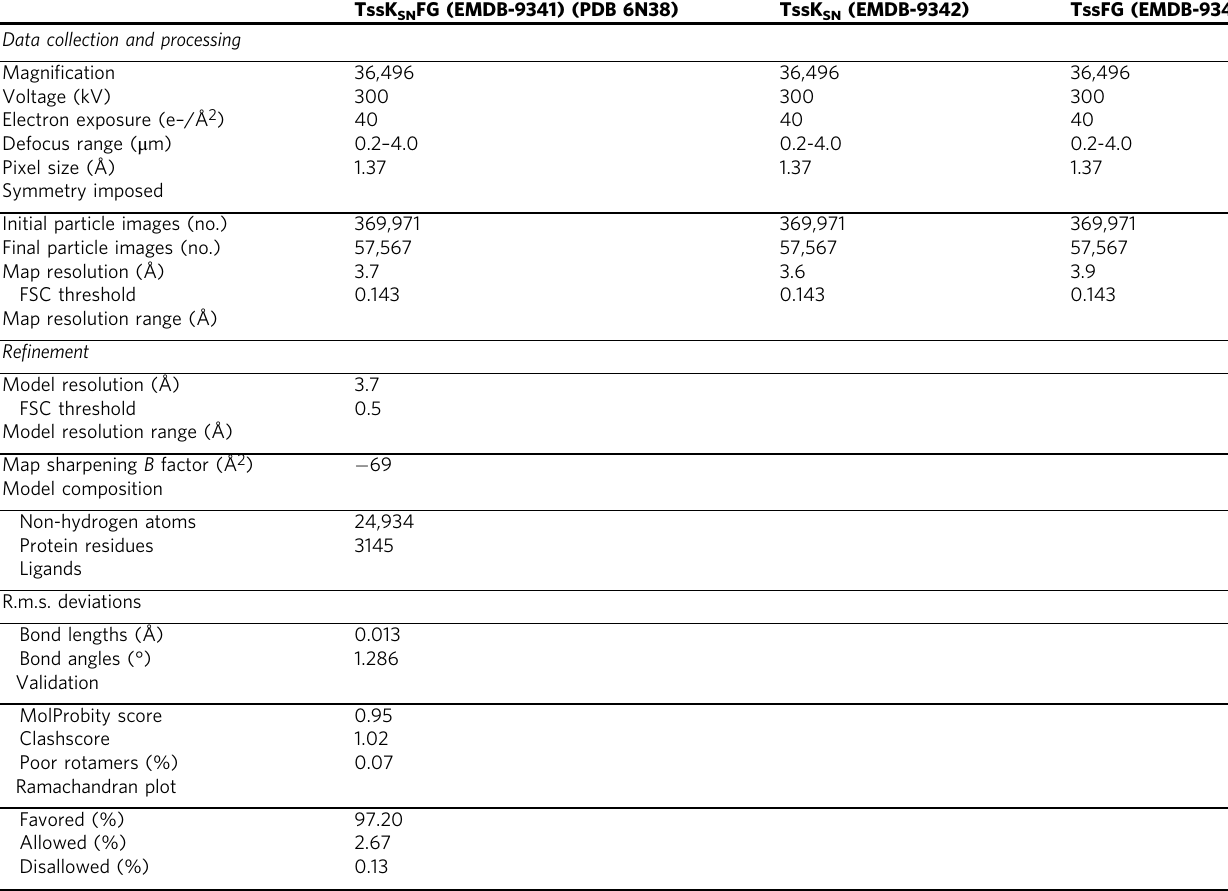
Table 1 CryoEM data collection, re fi nement, and validation